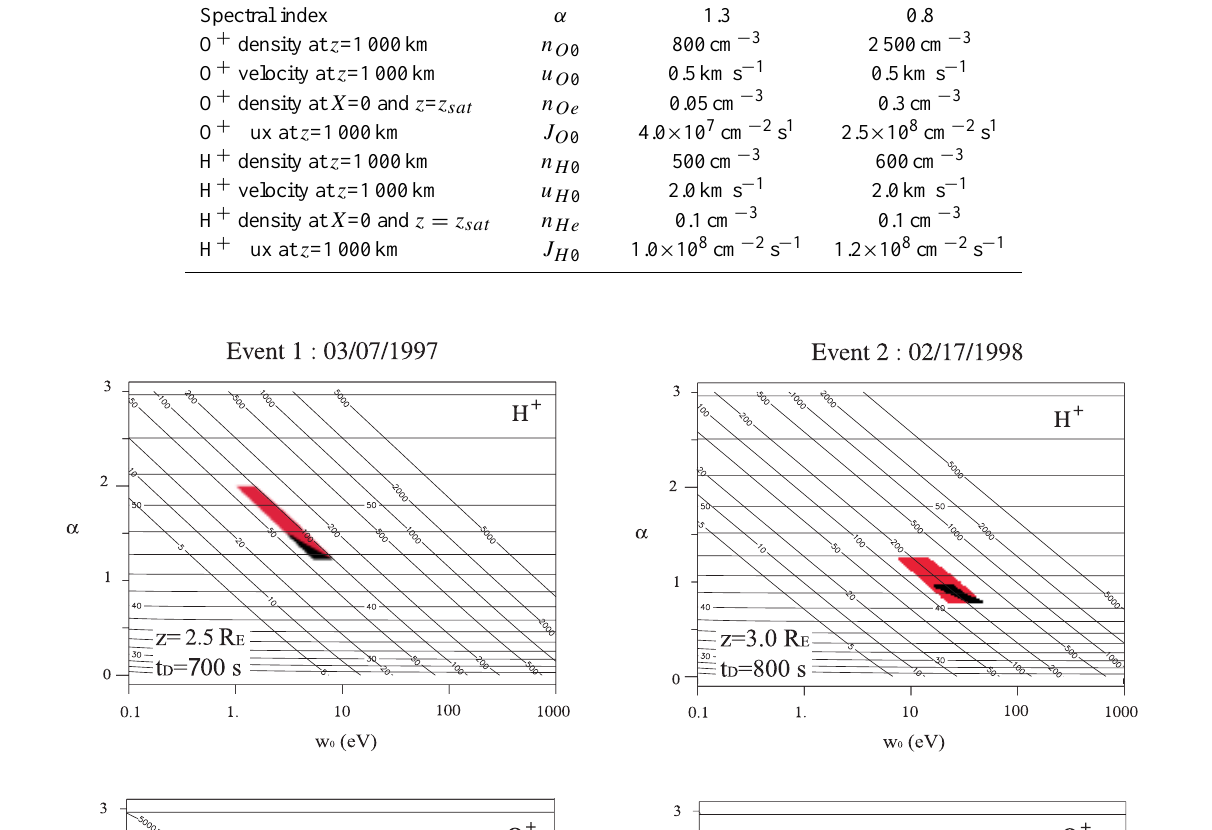
ically the couple of parameters ( w 0 , α ) associated with the heating profile versus altitude. Because there are uncertain- ties in the estimation of w ⊥ ip and 9 ip , we find a domain of solutions centered around a mean solution. In Fig. 7, we have represented by a colour surface the solution associated with the type ion (H + or O + ), and by a black surface the inter- section between the solutions associated with H + and O +